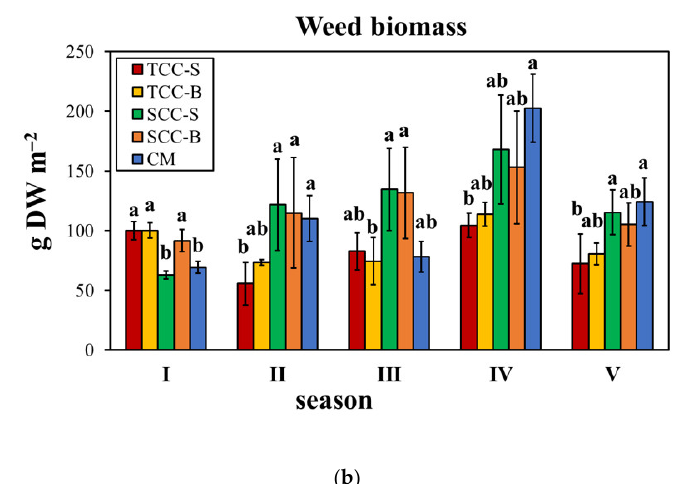
Figure 1. ( a ) Cover crop and ( b ) weed aboveground dry biomass production over five seasons in an apricot orchard. Bars are standard deviation ( n = 4). Within each season, different letters indicate